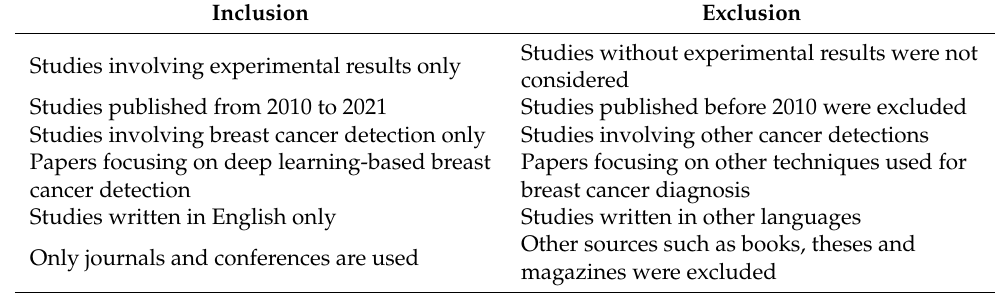
Table 2. Inclusion and exclusion.